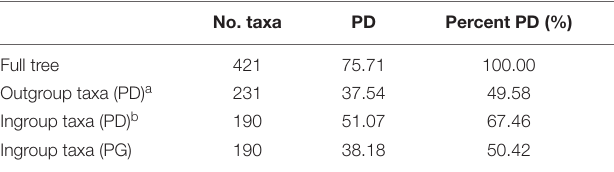
TABLE 1 | Calculated phylogenetic distance (PD) and phylogenetic gain (PG) for the bacterial genome trees, per